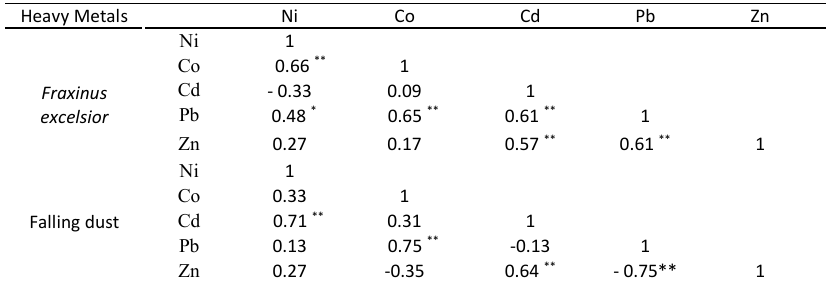
Table 5: Correlation coefficients among heavy metals concentrations in falling dust and Fraxinus excelsior L.